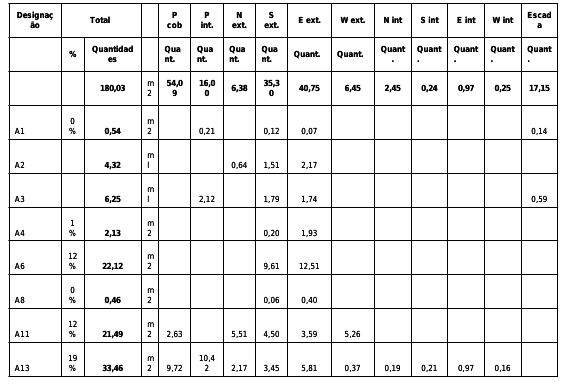
Figure 11. Quantitative table of anomalies in each facade, interior and exterior (Genin, 2002b).